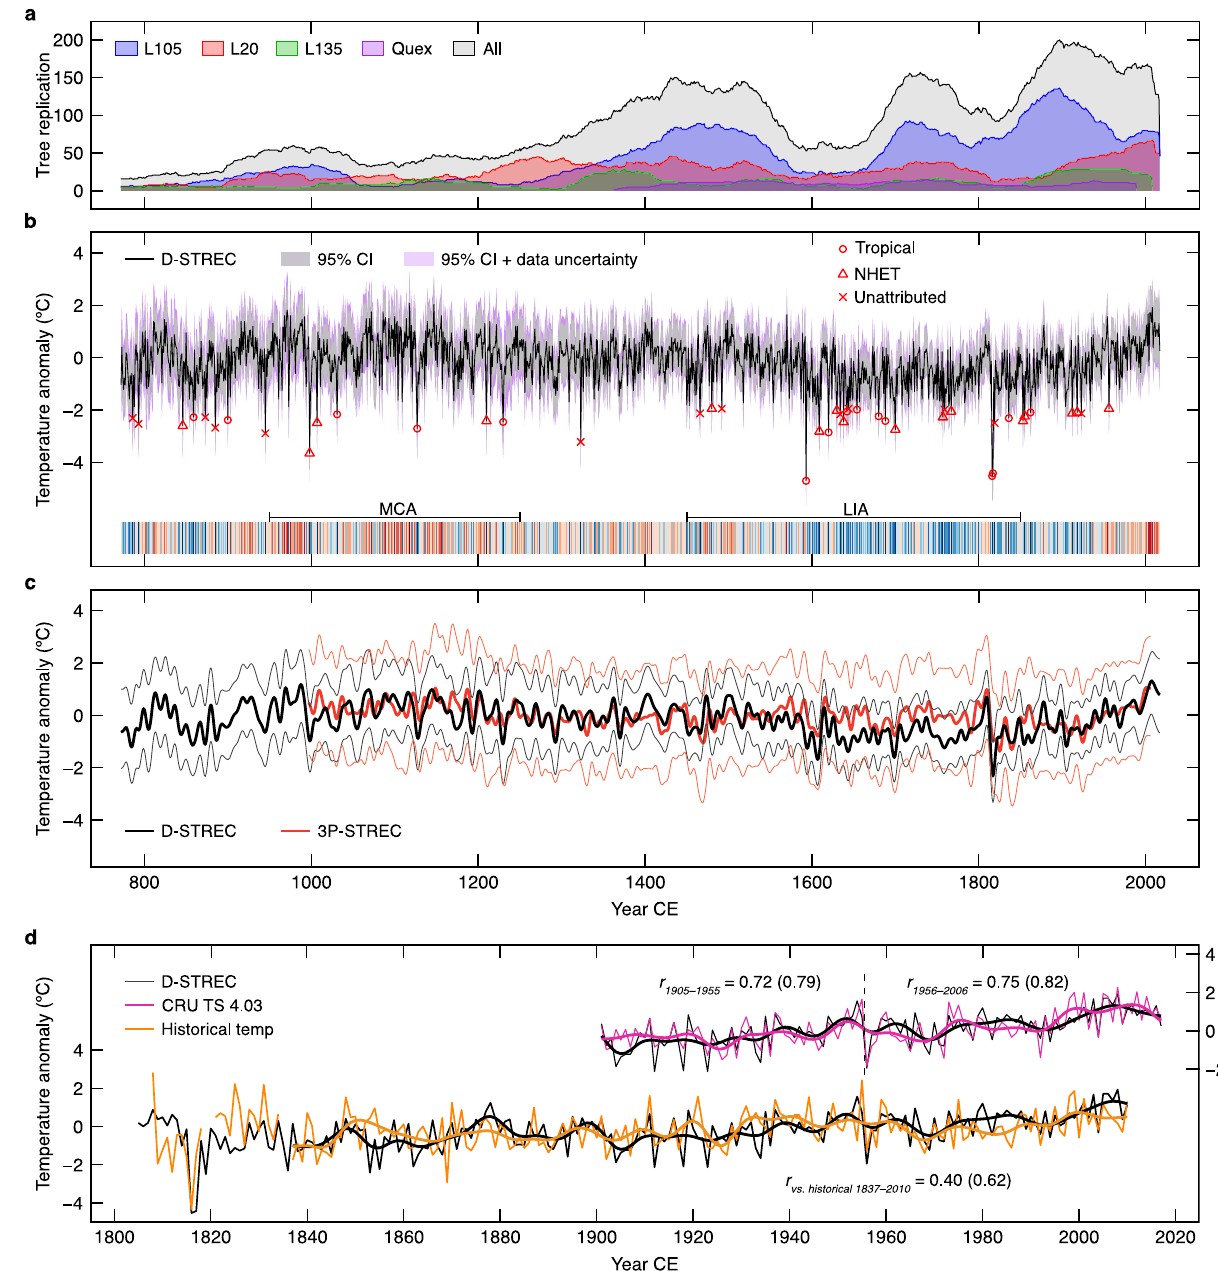
Fig.2|ReconstructedMay – August(MJJA)temperatureanomalieswithrespect to 1905 – 2006 CE in northeastern North America. a Replication of maximum latewood density series on tree basis. b D-STREC (772 – 2017 CE) superimposed on its two 95% con fi dence intervals (CIs), along with the temperature stripe graphic (expressed in 10 colors from cold-blue to warm-red) and the Medieval Climate Anomaly (MCA; ~950 – 1250 CE) and the Little Ice Age (LIA; ~1450 – 1850 CE) de fi ned by the Fifth Assessment Report of the Intergovernmental Panel on Climate Change 22 . Circles, triangles, and crosses denote cold extremes ( ≤ mean − 2SD) matched to tropical and Northern Hemisphere extratropical (NHET) volcanic